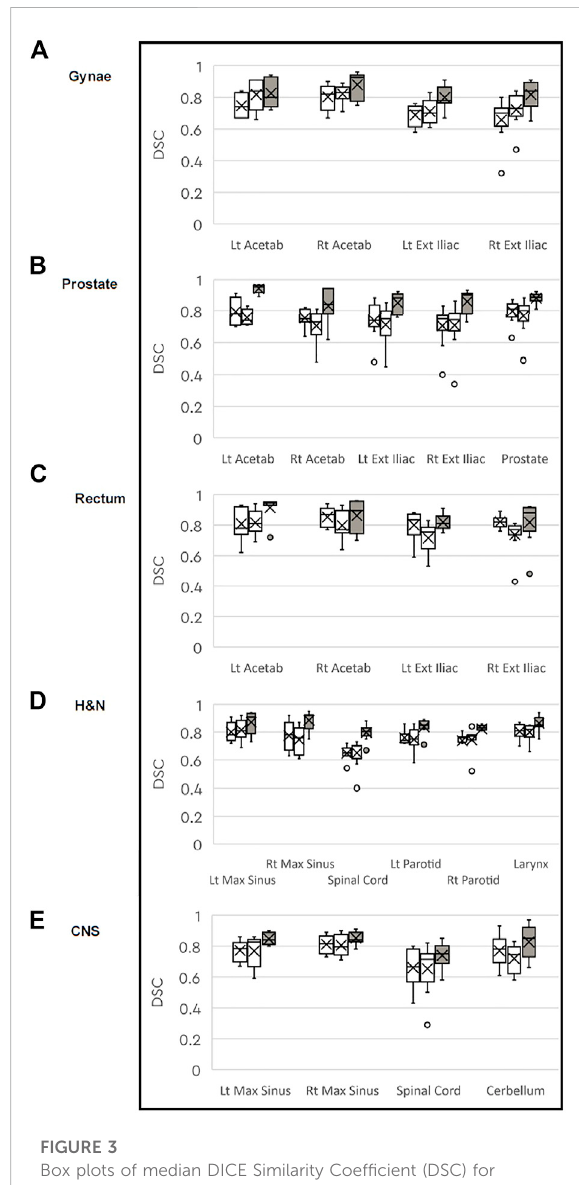
FIGURE 3 Box plots of median DICE Similarity Coef fi cient (DSC) for each anatomical structure comparing the CT to MRI datasets (white) and MRI to MRI (grey) for the (A) gynaecological; (B) prostate; (C) rectal: (D) H&N: and (E) CNS patient